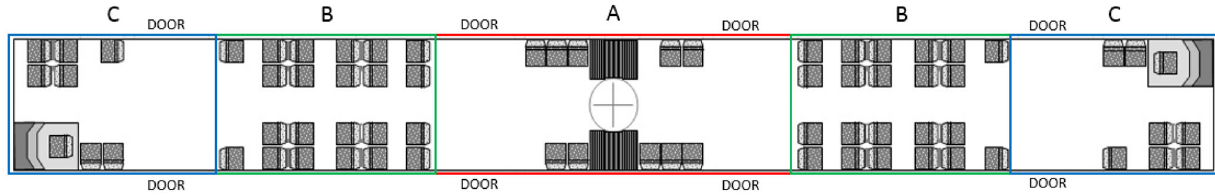
Fig. 5 Current metro configuration, with highlighted areas A, B and C